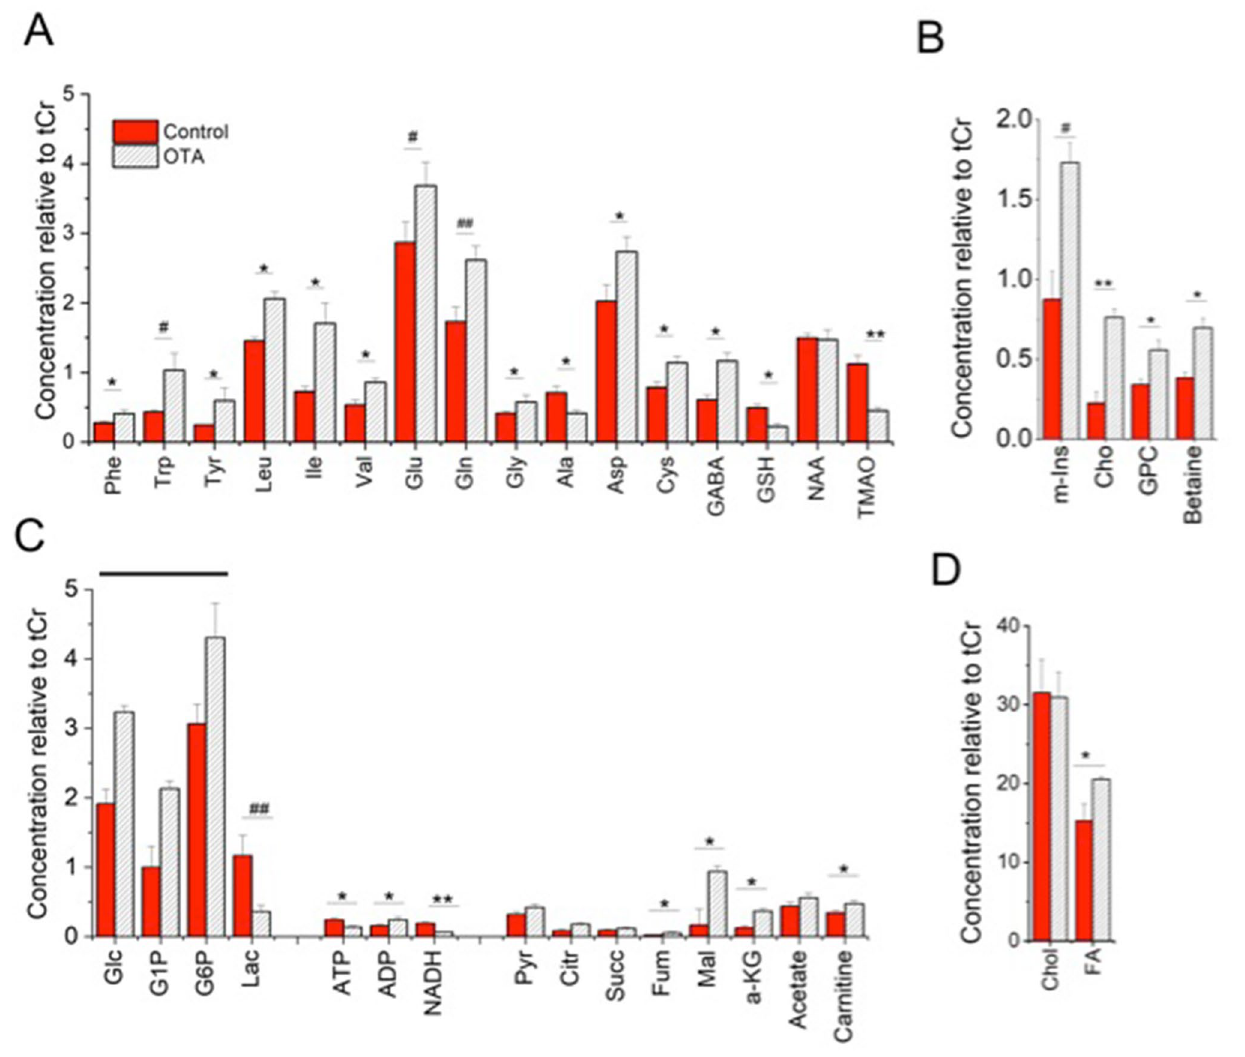
Figure 5. Effect of OTA treatment on the metabolic profile of intact zebrafish embryos. Zebrafish embryos (72 hpf) were exposed to 1 µM OTA or solvent vehicle (“Control”), for 24 h. Concentrations of metabolites relative to total creatine (tCr) are shown, and include ( A ) amino acids and related metabolites ( B ) polar head-groups of membrane phospholipids; ( C ) metabolites associated with energy metabolism; and ( D ) lipids, i.e., fatty acids and cholesterol. For statistical analysis, one-way ANOVA with a Tukey post-hoc correction for multiple comparisons were performed using OriginPro v. 8 (Northampton, MA, USA). Values shown are the mean ± standard deviation (n = 6). ## P < 0.0001, # P < 0.001, ** P < 0.01 and * P < 0.05. Note As indicated by line, Glc, G1P and G6P could not be unambiguously identified by HRMAS NMR, so statistical significance of differences is not given, however, all three were resolved, and relative changes (i.e., increases) were confirmed, by 2D COSY experiments (see Supplementary Fig. S1). Abbreviations: Phe = phenylalanine; Trp = tryptophan; Tyr = tyrosine; Leu = leucine, Ile = isoleucine; Val = valine; Glu = glutamate; Gln = glutamine; Gly = glycine; Ala = alanine; Asp = aspartate; Cys = cysteine; GABA = γ-aminobutyric acid; GSH = glutathione; TMAO = trimethylamine N -oxide; Glc = glucose; G1P = glucose-1-phosphate; G6P = glucose-6-phosphate; Lac = lactate; ATP = adenosine triphosphate; ADP = adenosine diphosphate; NADH/NAD + = reduced/oxidized nicotinamide adenine dinucleotide; m-Ins = myo-inositol; Cho = choline; GPC = glycerophosphocholine; Pyr = pyruvate; Cit = citrate; Suc = succinate; Fum = fumarate; Mal = malate; a-KG = alpha ketoglutarate; Chol = cholesterol; FA = fatty